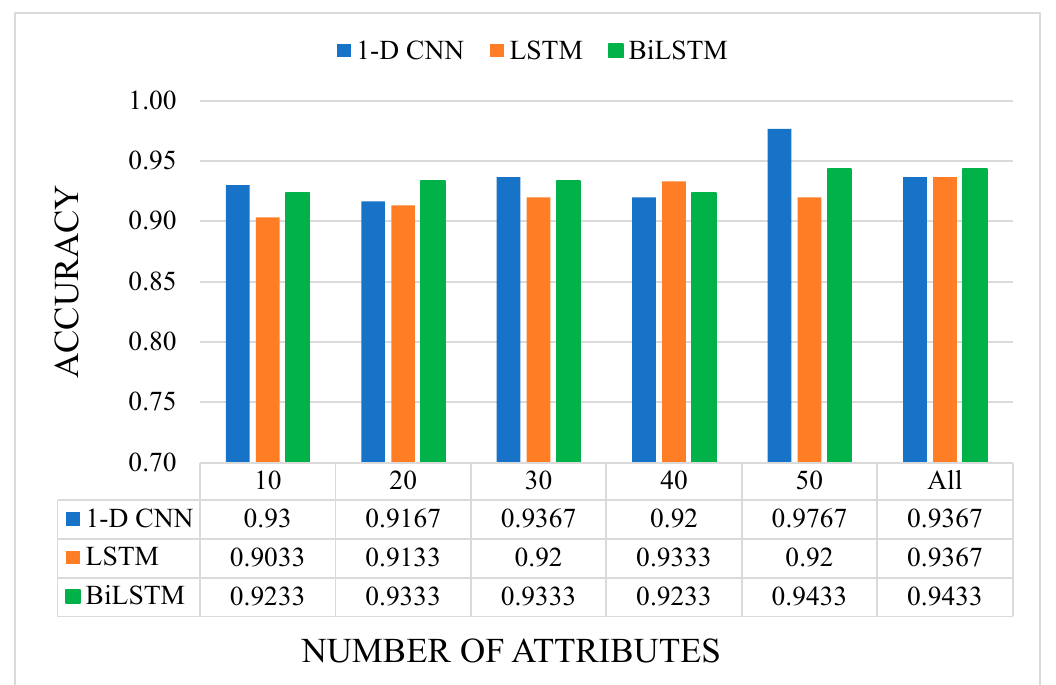
Figure 9. The accuracy results of the DL models on cancer prediction with different numbers of attributes. (Illustrations by the authors).